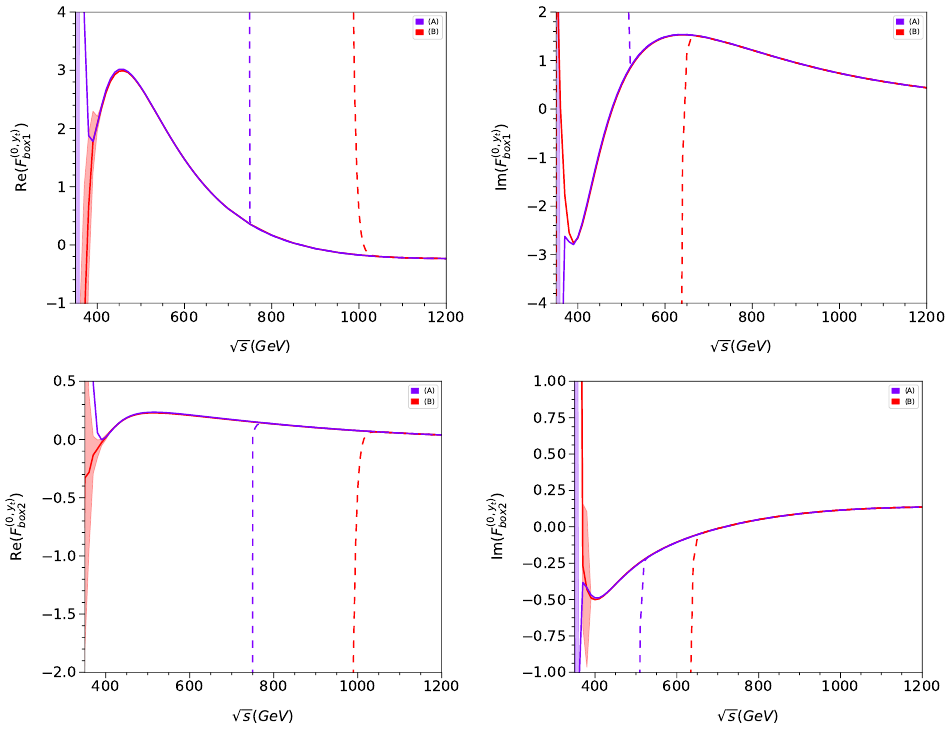
Figure 10 . Real and imaginary parts of F box1 and F box2 for fixed scattering angle θ = π/ 2